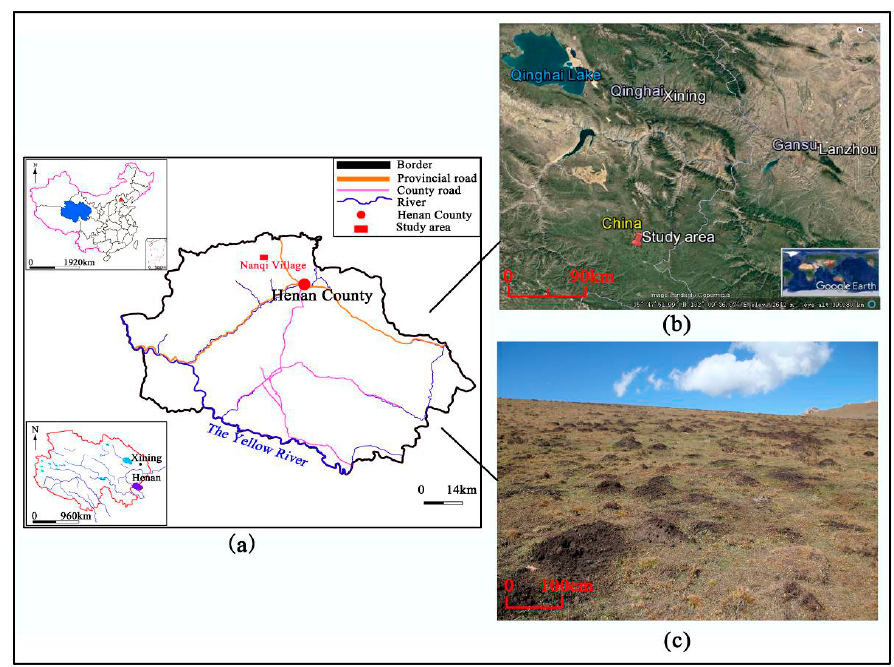
Figure 1. ( a ) Location of the study area; ( b ) An aerial image of the study area; ( c ) Ground photo of the study area.